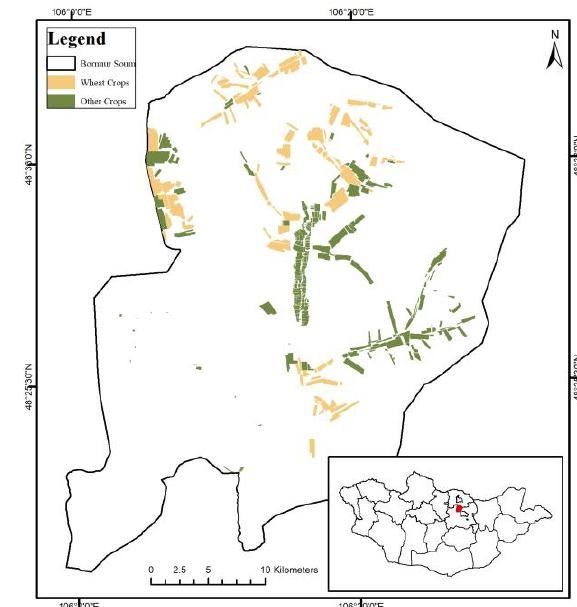
Figure 1. Location of study area and visualization of agricultural